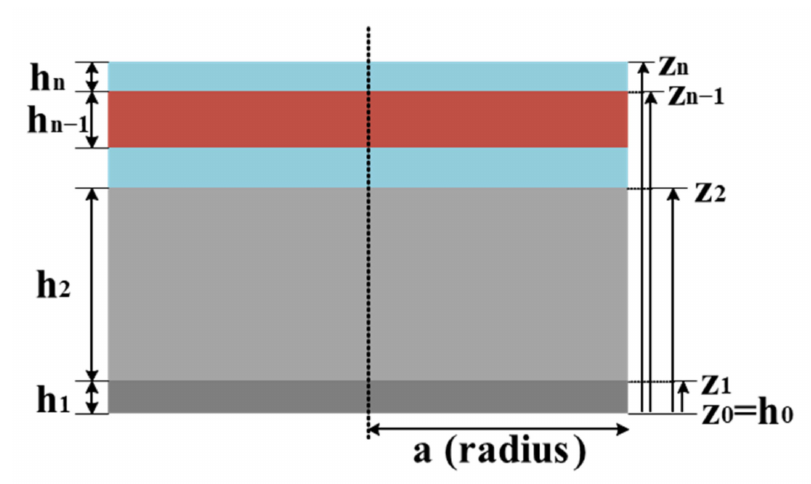
Figure 2. Circular plate model design structure of pMUT.